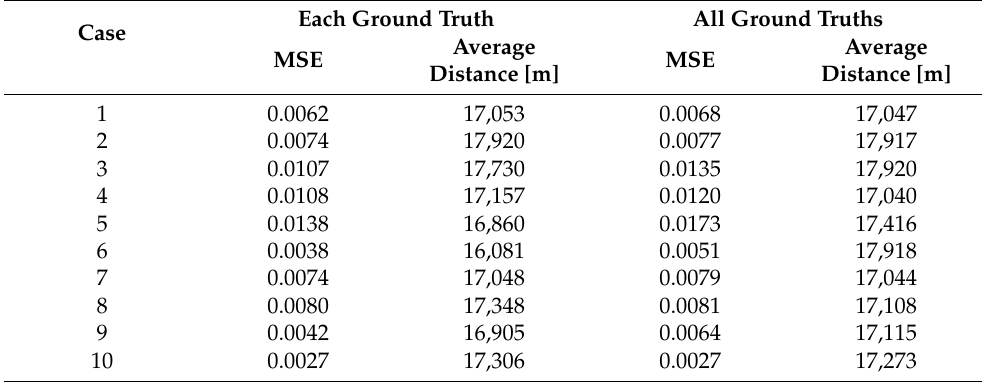
Table A4. Comparison of the MSE and the average distance using the values of Table A3.